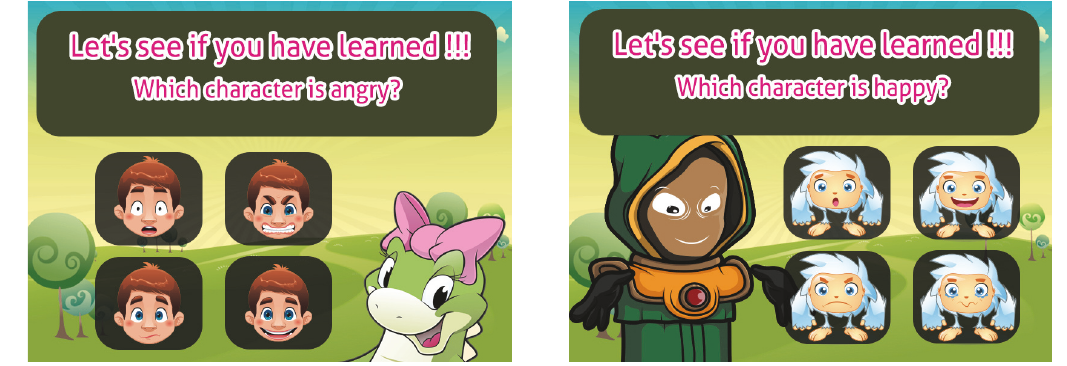
Figure 16: Checking learning.